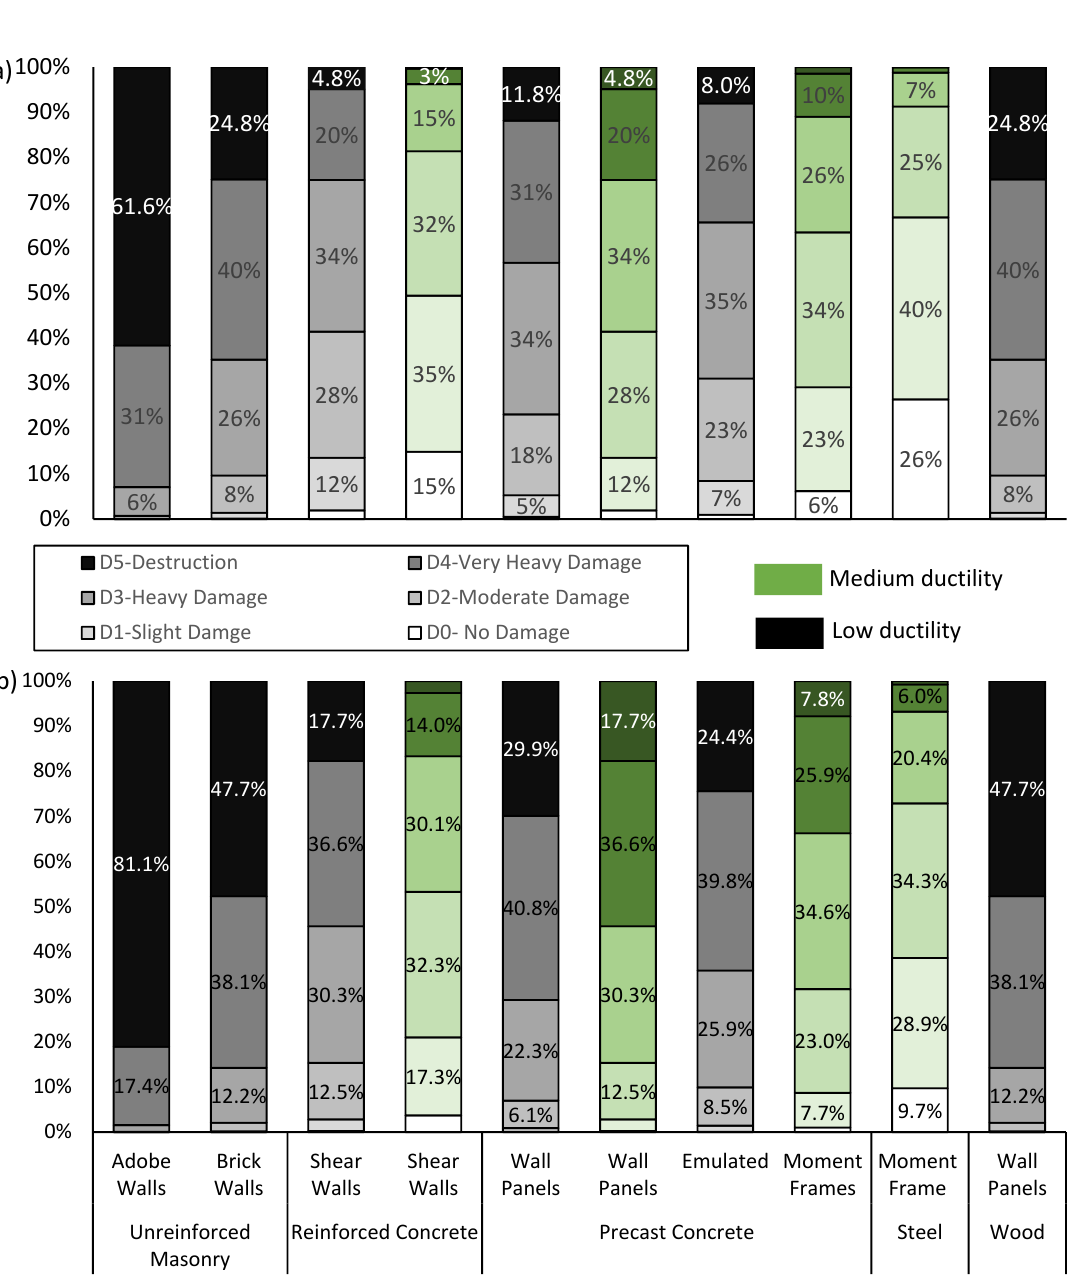
Figure 8. Probability of the damage for different groups of residential buildings at ( a ) DBE (return period of 475 years); and ( b ) MCE (return period of 2475 years).